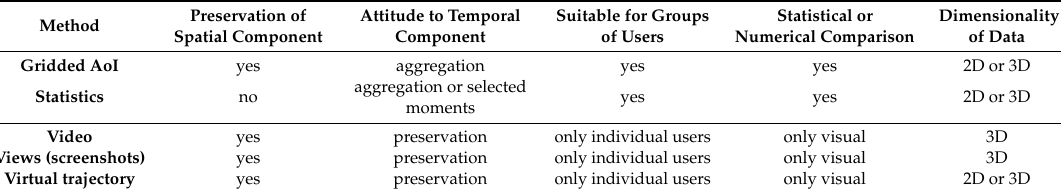
Table 3. Comparison of methods of analysis or visualization of user interaction and virtual movement according to their